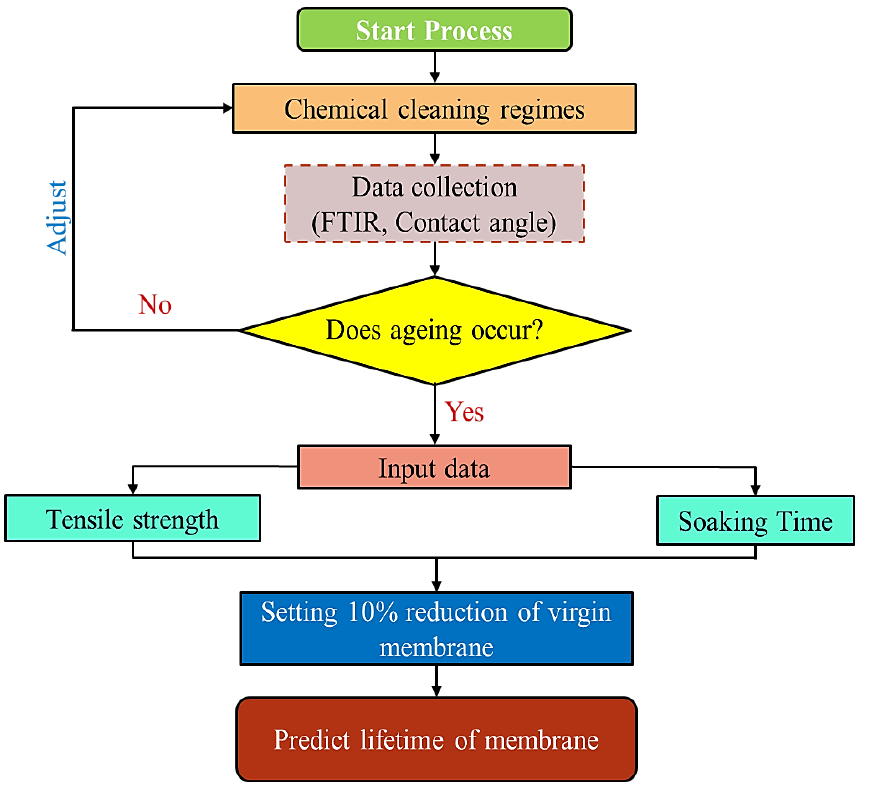
Figure A6. Flow diagram of membrane lifetime prediction.